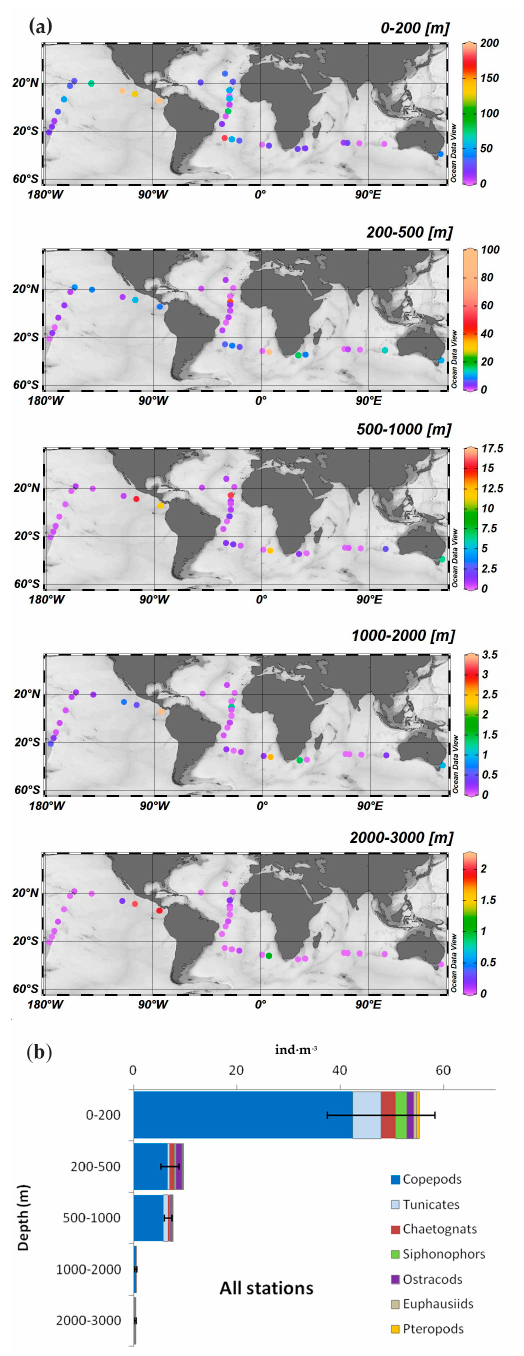
Figure 3. ( a ) Zooplankton abundance at each sampled station and depth layer (scale color bars indicate ind·m − 3 ) and ( b ) depth distribution of the average abundance of the main zooplankton groups (averaged data at each stratum as ind·m − 3 ).